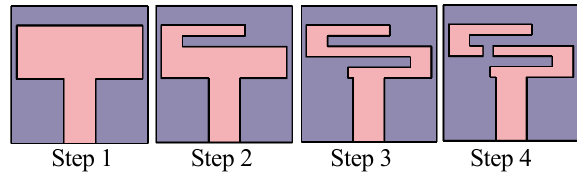
FIGURE 2. Antenna geometry evolution for the proposed design.